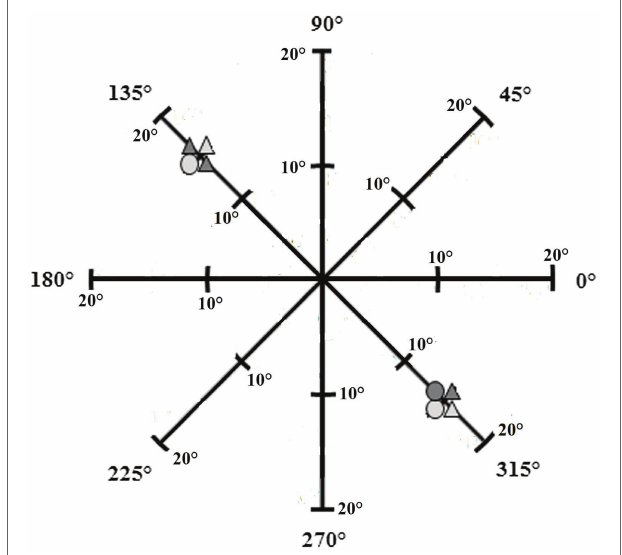
FIGURE 1 | The stimuli were presented at eight distances from the center of the screen on four meridians (one horizontal, one vertical, and two diagonal) with eight directions (0 ° , 45 ° , 90 ° , 135 ° , 180 ° , 225 ° , 270 ° , and 315 ° ) in the attention-window task. The figure represents a stimulus pair located on the diagonal meridian with a stimulus separation of 30 ° (from Hüttermann and Memmert,